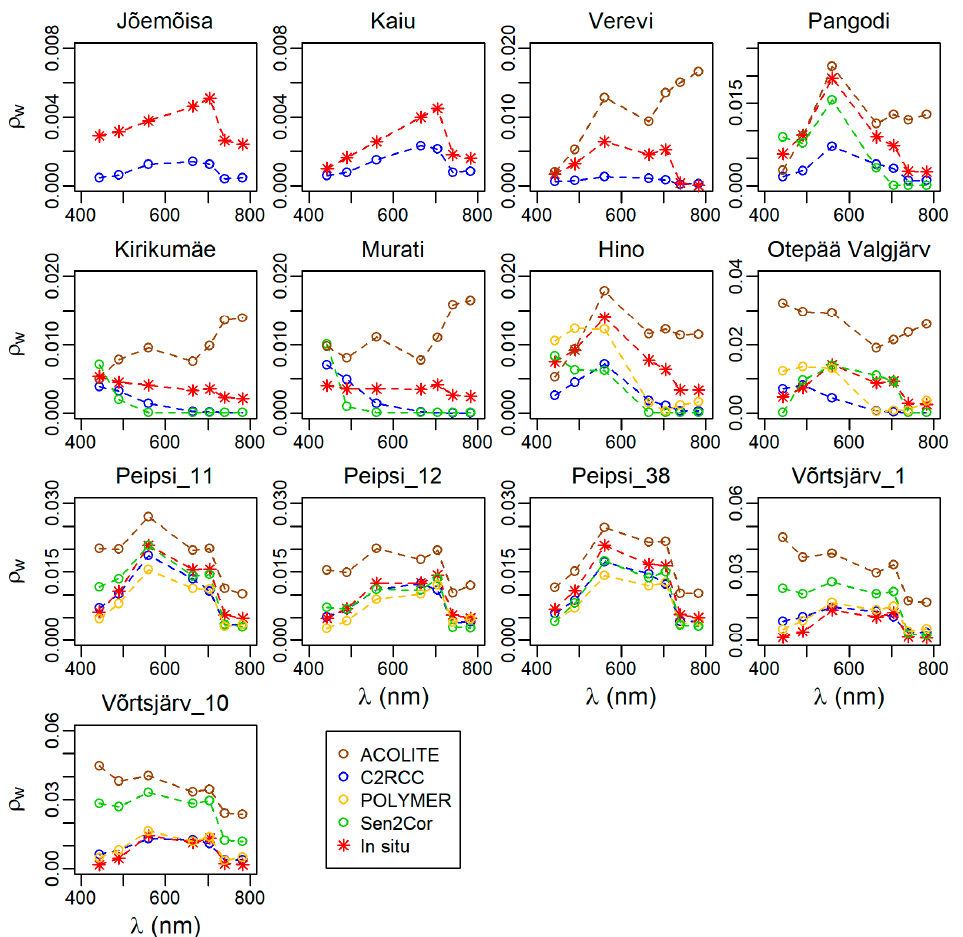
Figure 3. Quality flagged water-leaving reflectance ( ρ w ) of each AC processor compared with in situ measured ρ w at each S2 MSI band in the studied lakes. Used S2 MSI bands for validation are B1 (443 nm), B2 (490 nm), B3 (560 nm), B4 (665), B5 (705 nm), B6 (740 nm), B7 (783 nm).